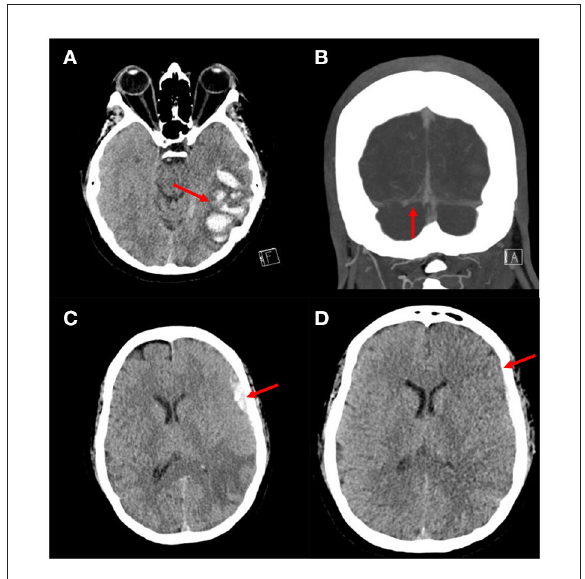
FIGURE2 Images from patient who underwent MMA embolization followed by anticoagulation for management of aSDH with CVST. (A) Axial head CT demonstrating an ill-defined intraparenchymal hemorrhage in the left temporal lobe concerning for a venous infarct. (B) Coronal CTV showing occlusion of the right transverse sinus. (C) Axial head CT demonstrating an acute left frontal subdural hematoma. (D) Axial head CT demonstrating decreased size of the left frontal subdural